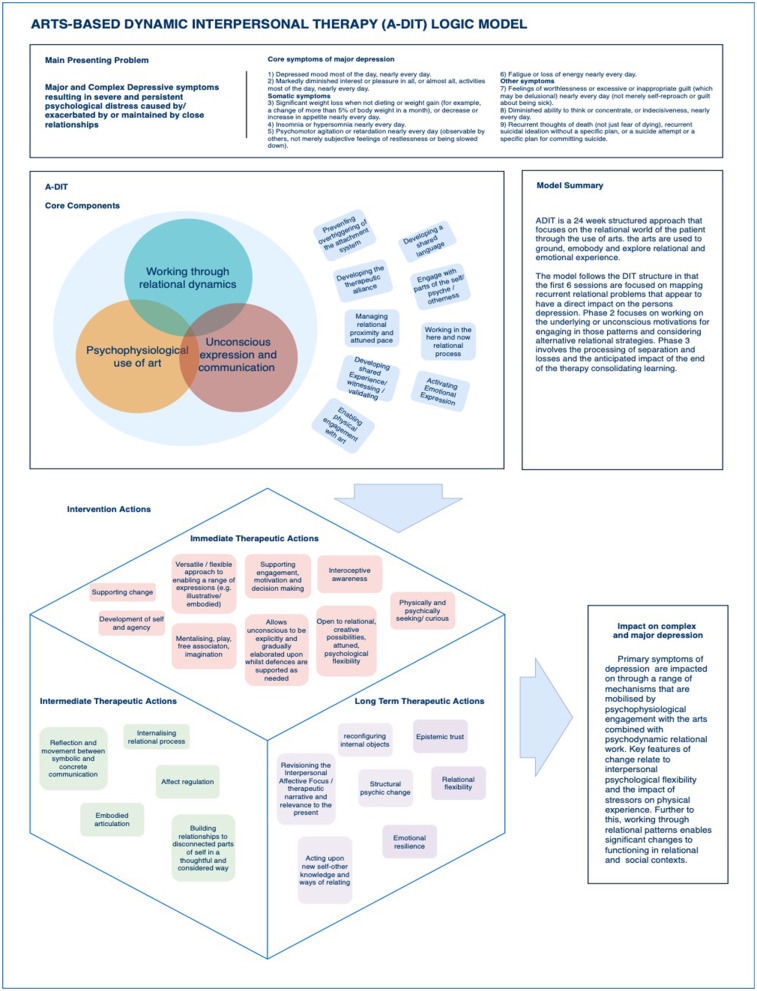
ADIT logic diagram.